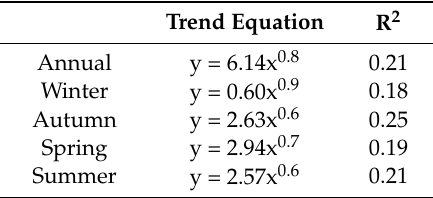
Table 5. Relationship between rainfall and altitude.